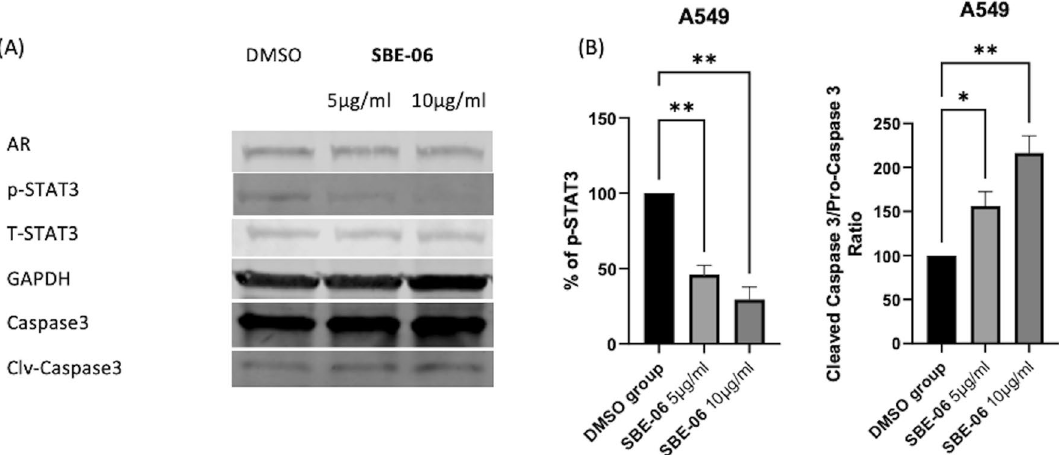
Figure 4. SBE-06 induced apoptosis in A549 cell line via downregulation of p-STAT3 and activation of caspase 3. ( A ) The immunoblot of AR, p-STAT3, T-STAT3, pro-caspase 3, and cleaved caspase 3 in the A549 cell line treated with 0.1% DMSO or 0.1% DMSO solution of SBE-06 (5 and 10 μg/mL) for 24 h. ( B ) Quantification of immunoblot obtained for p-STAT3 and caspase, averaging data from three independent experiments. (Bars show mean plus standard deviation; * p < 0.05; ** p <